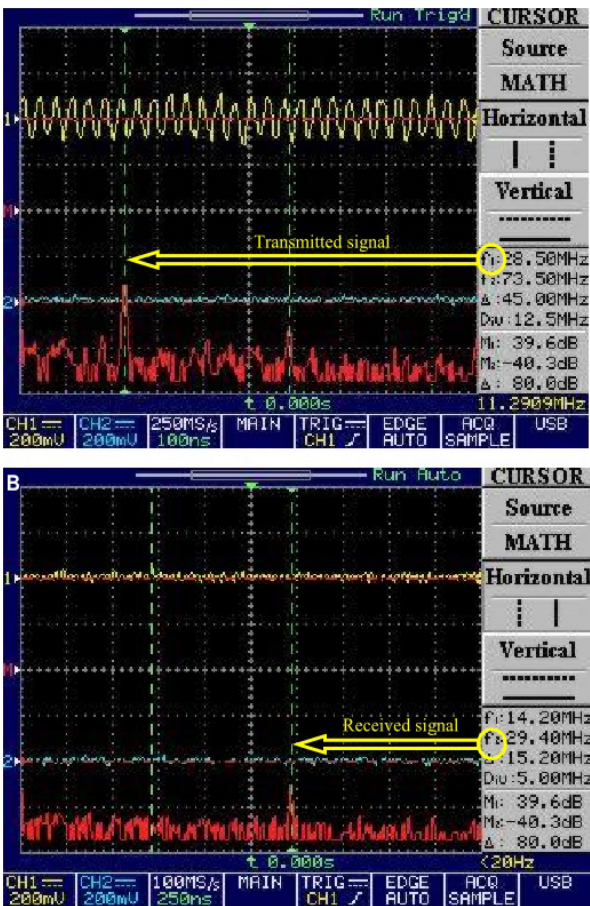
Figure 26. Lambda diode oscillator transmitted and received sig- nals conducted using a digital storage oscilloscope: (a) transmitted signal; (b) received